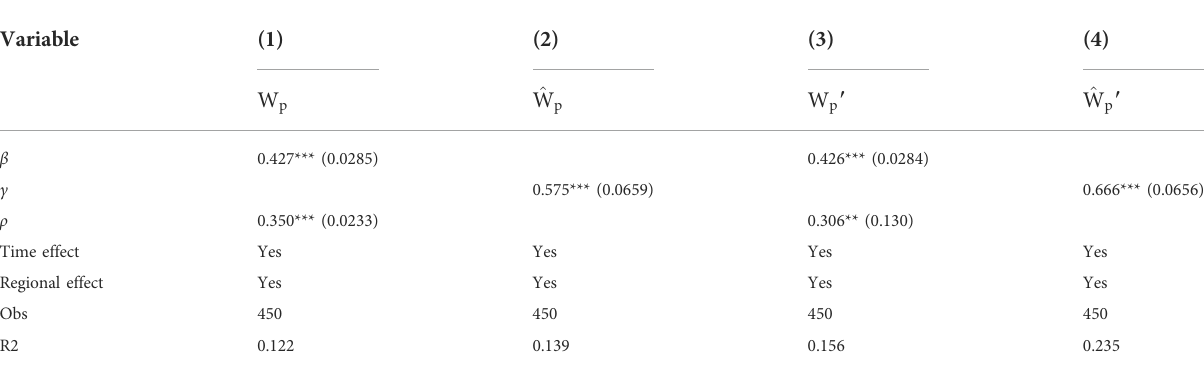
TABLE 6 Robustness